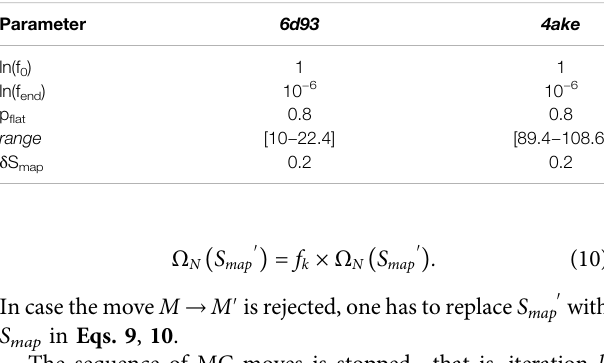
TABLE 4 | Set of parameters employed for the WL exploration of the mapping entropy space for both analyzed proteins. ln ( f 0 ) and ln ( f end ) respectively represent the modi fi cation factor at the beginning and at the end of the self- consistent scheme in a logarithmic setup, see Sec. Wang – Landau Sampling . p fl at istheminimalhistogram fl atnessrequiredtohalvethemodi fi cationfactor;with p fl at (cid:1) 0.8, all bins in the histogram H ( S map ) must have a population between 0.8 and 1.2 times its average 〈 H 〉 . range is the interval of permitted values of the mapping entropy in the WL scheme, while δ S map is the bin size employed for its discretization. Both range and δ S map are expressed in kJ/mol/K.